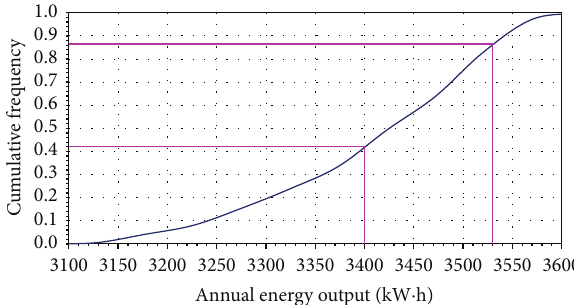
Figure 5: Monte Carlo simulation of cumulative frequency distri- bution for annual energy